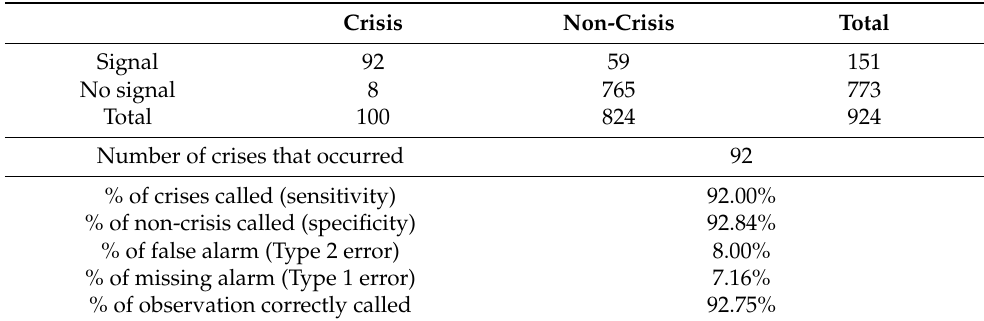
Table 12. Performance of EWS model in Latin American countries, cut-off = 12.02%. Table 11. Probability of predictability of the 12-month EWS model (cut-off = Country